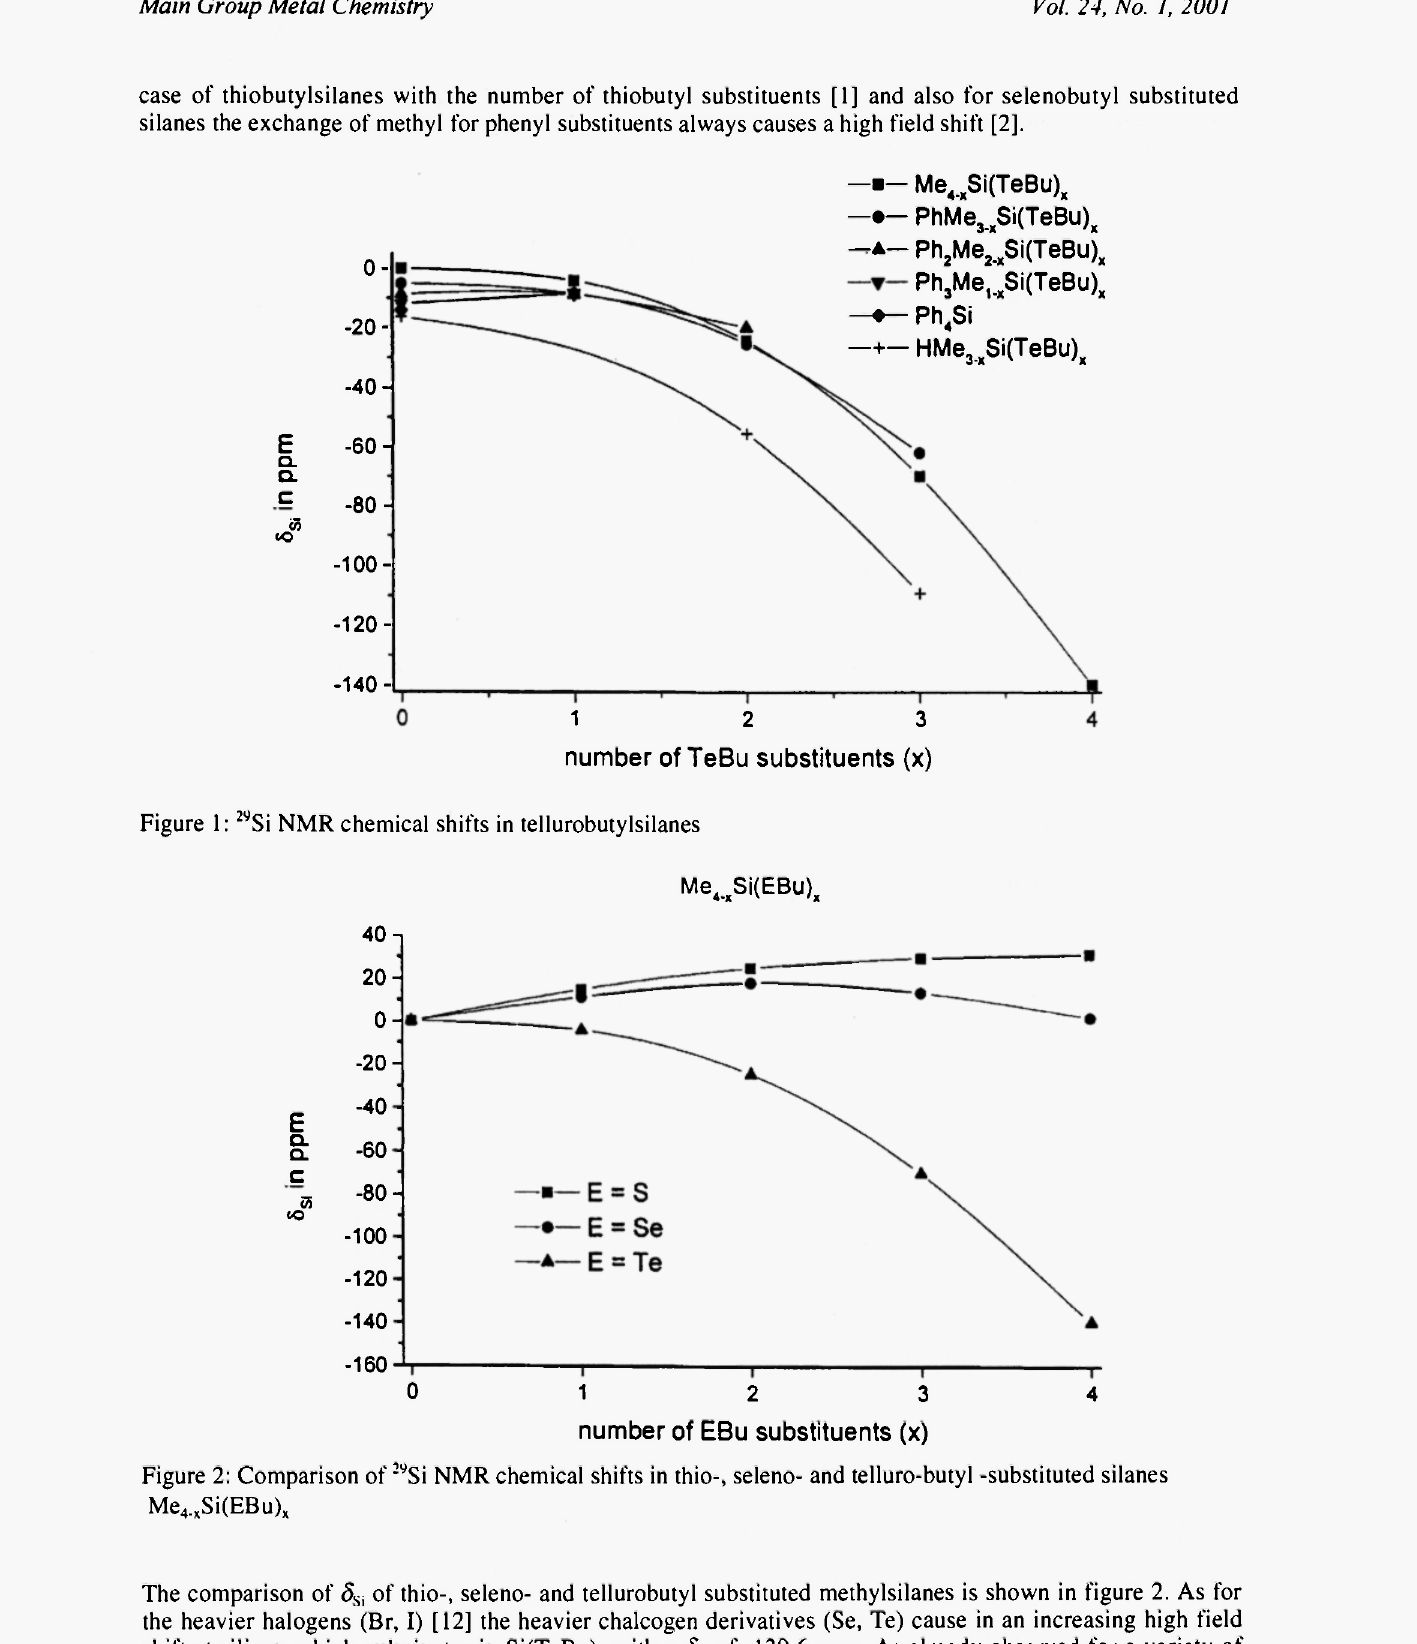
Figure 2: Comparison of 29 Si NMR chemical shifts in thio-, seleno- and telluro-butyl -substituted silanes Me 4 . x Si(EBu)